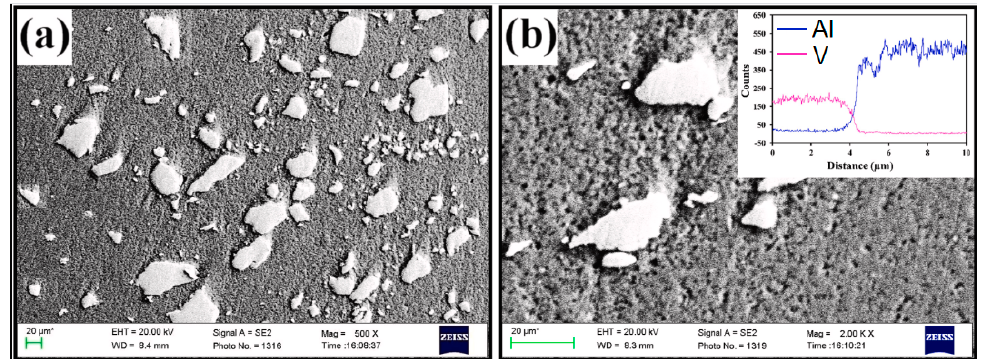
Figure 9. Microstructure of FSPed AA6063 with 12 vol. % V content at magnification: ( a ) 500 × and ( b ) 2000 × (the insert shows the EDX line scan along the particle interface) (reproduced from [63], with permission from Elsevier, 2019).